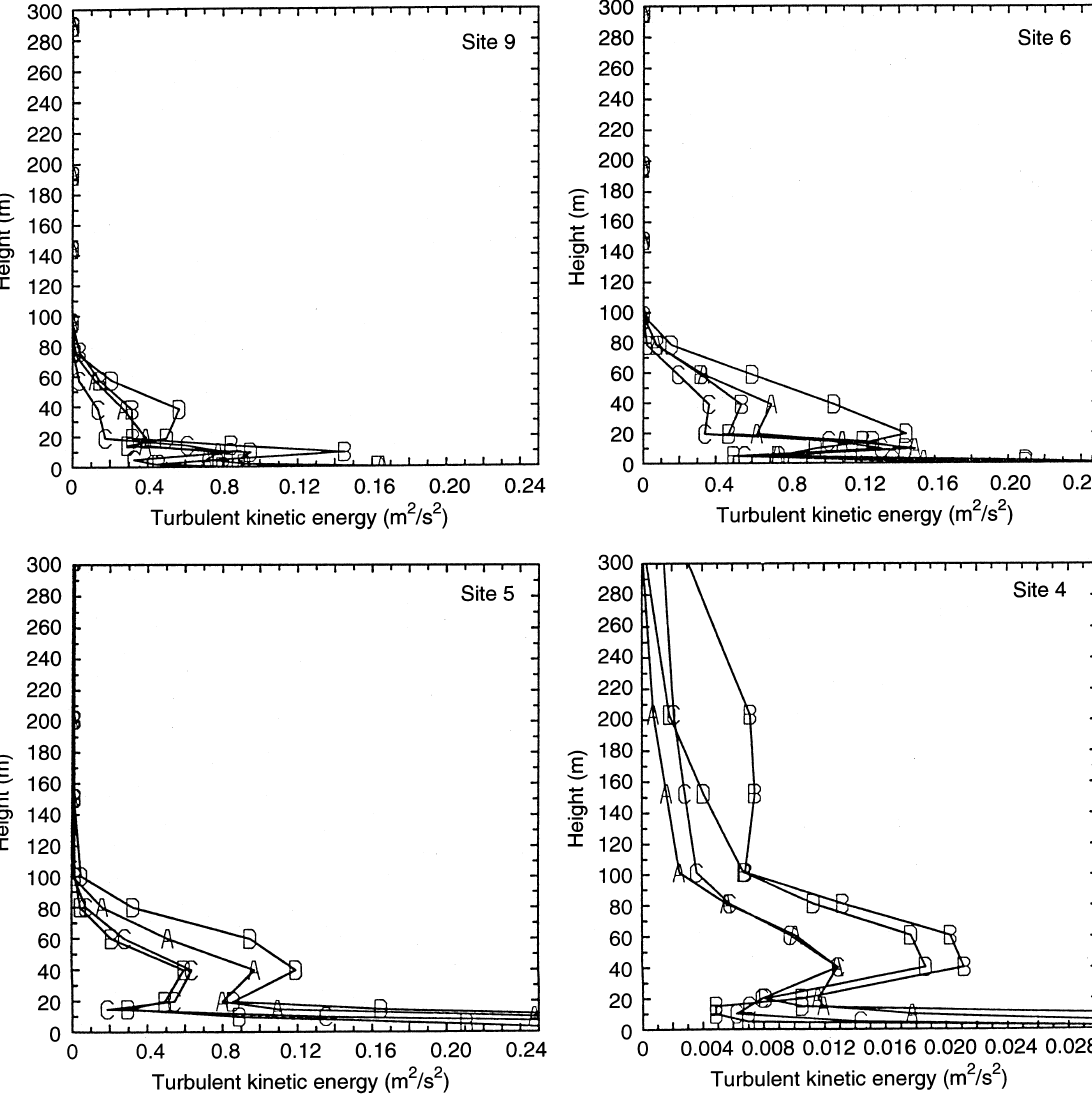
Fig. 5A–D. Time evolution of the vertical profile of the turbulent kinetic energy computed near the experimental sites over the ice cap, on July 12, A 0600 LST; B 1200 LST; C 1800 LST; and D